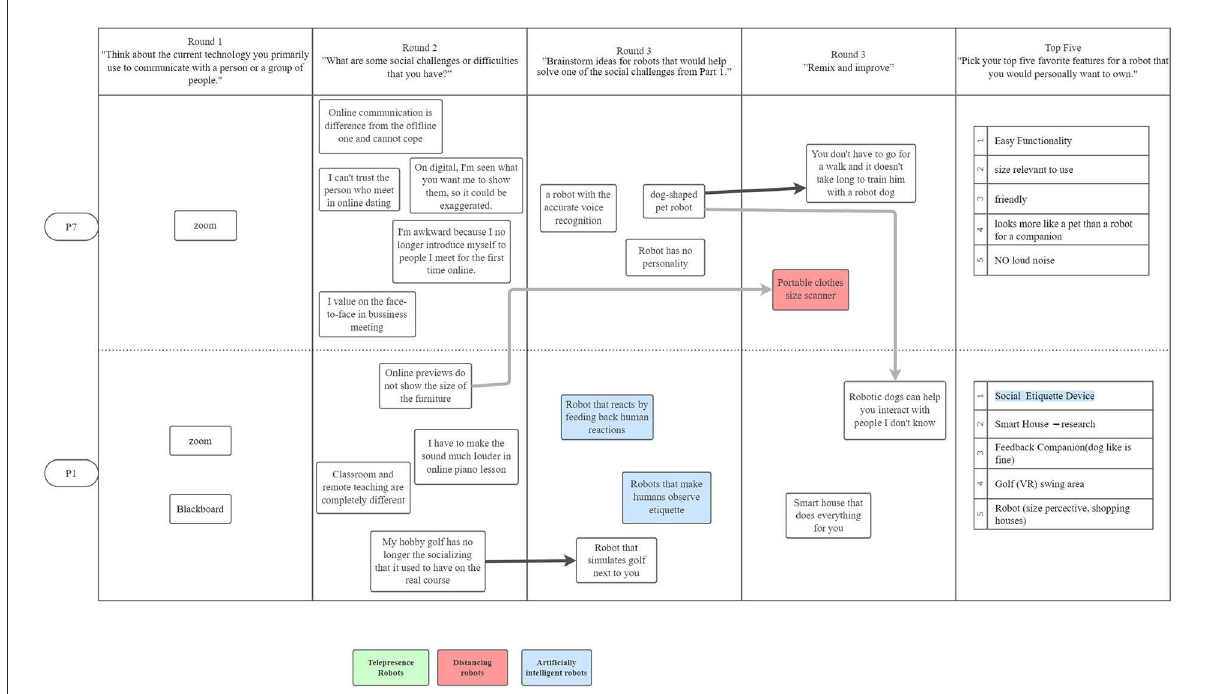
FIGURE2 The second US PD session was held on November 10, 2020 and had 2 participants.